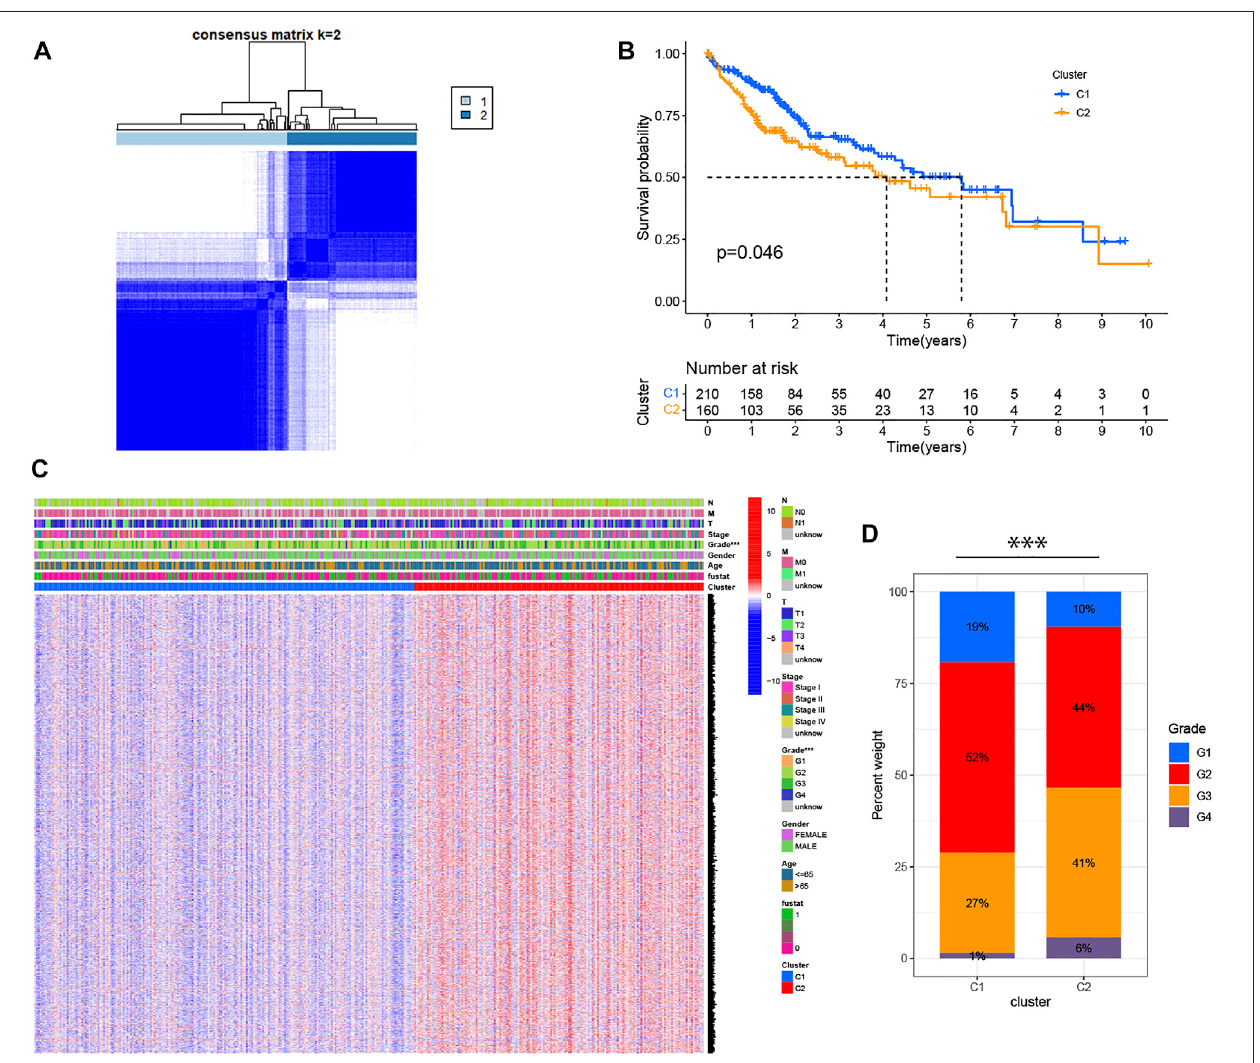
FIGURE 2 | Identi fi cation of HCC classi fi cation based on pyroptosis-related DEGs. (A) 370 patients with HCC were divided into two clusters by the consensus clustering matrix (K (cid:1) 2). (B) Kaplan-Meier OS analysis of HCC patients in two clusters. (C) Heatmap displaying the expression of DEGs in classi fi cation and the relationship between clinicopathologic characters and classi fi cation. “ Fustat ” represents the survival status, where “ 0 ” indicates that the patient is still alive and “ 1 ” indicates that the patient has died. *** p < 0.001. (D) The number of patients with different clinicopathological grades in two clusters.